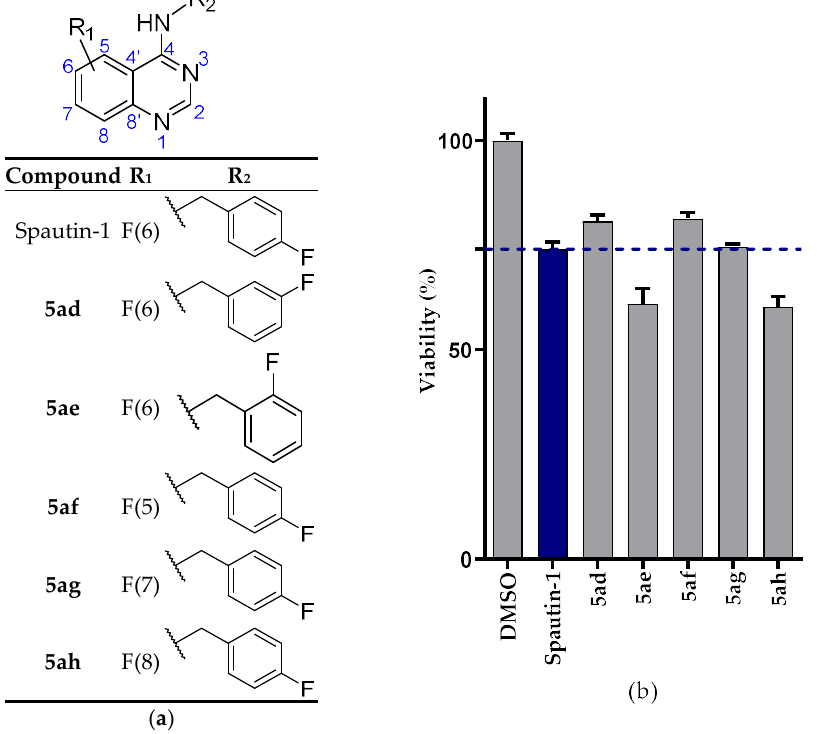
Figure 4. ( a ) Spautin-1 analogues synthesized for the “F-screening”; ( b ) viability assay (5 µ M) with Spautin-1 as reference.